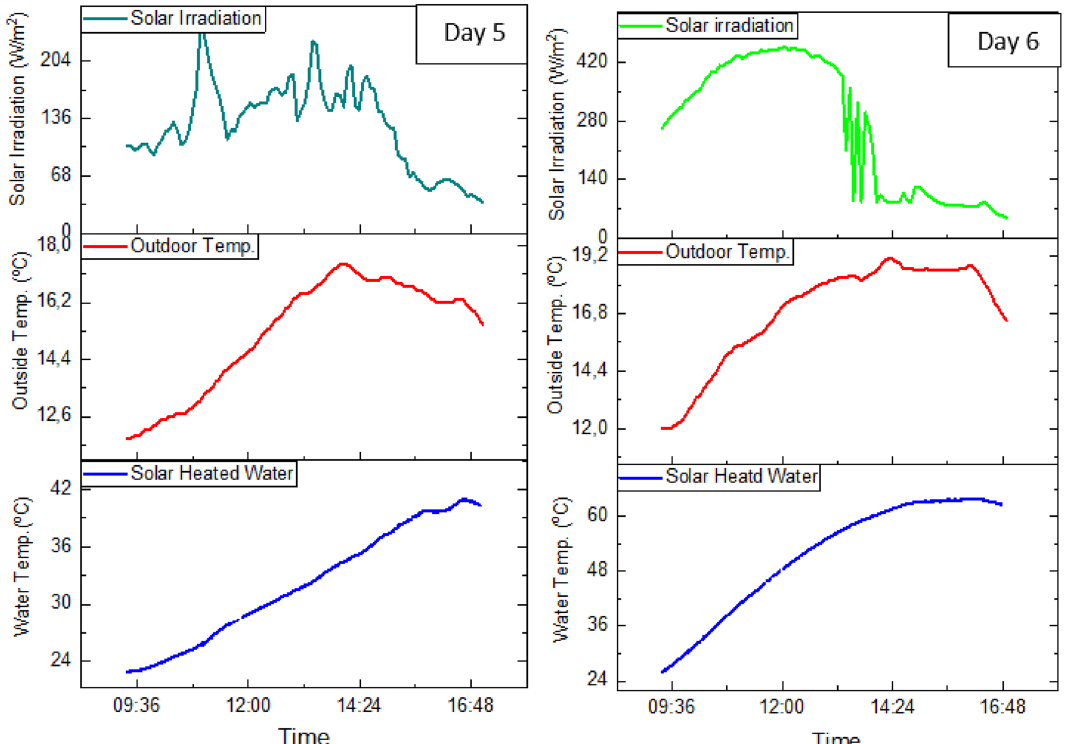
Fig. 6 Solar irradiation, outdoor temperature and solar heated water temperature for day 5 and day